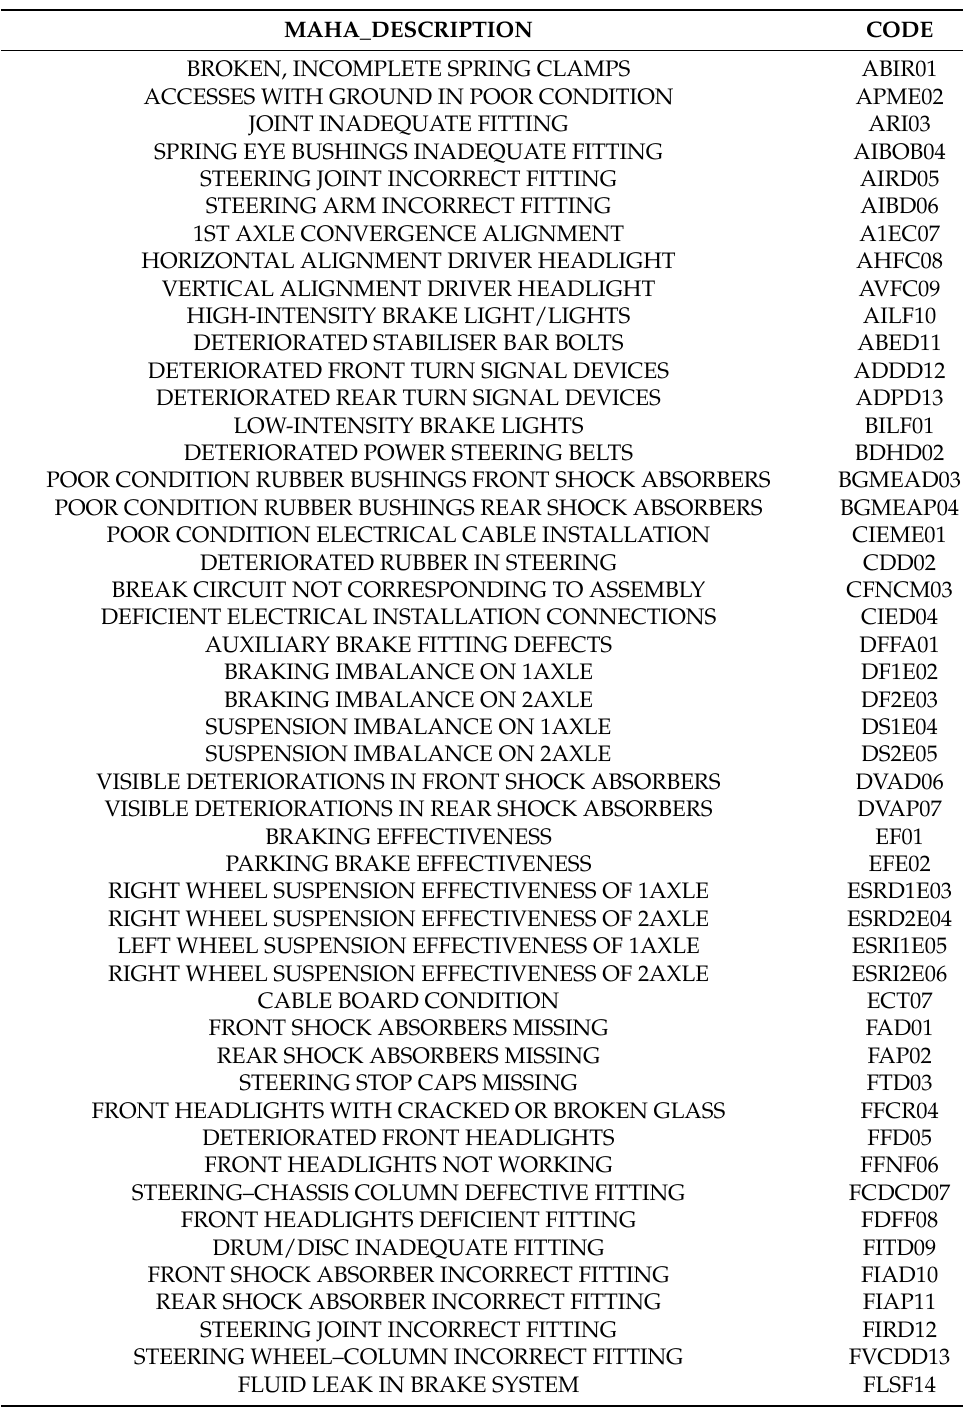
Table A1. Vehicle Technical Inspection failure